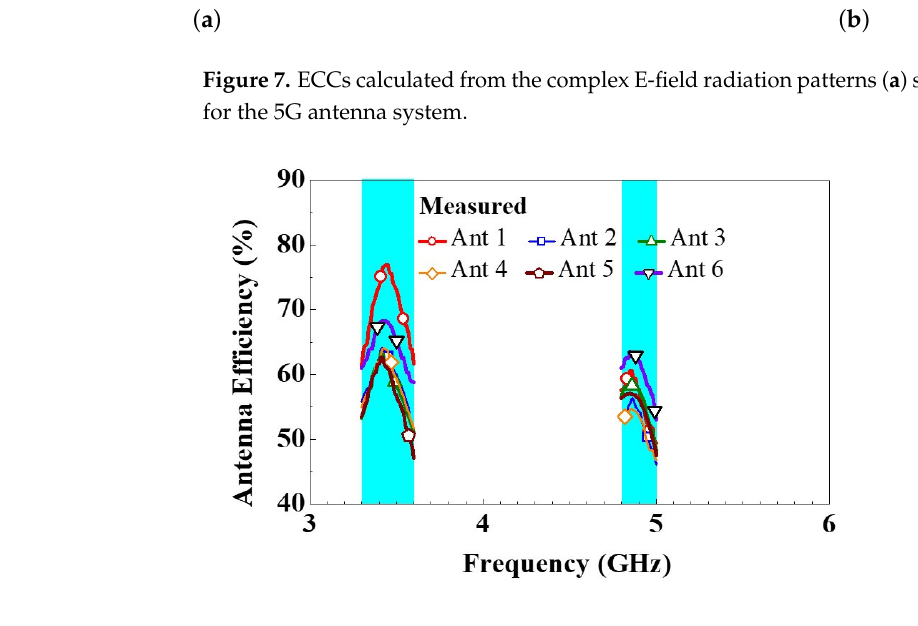
Figure 8. Antenna efficiencies measured for the 5G antenna system.